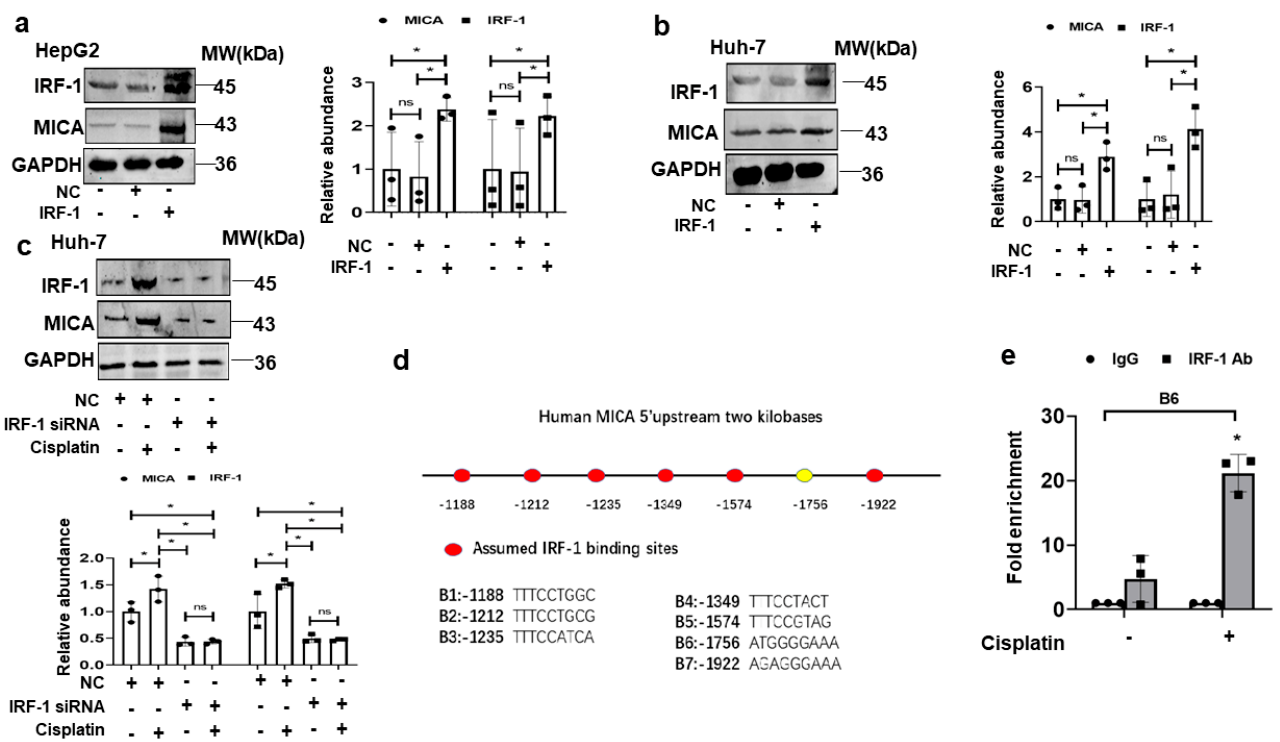
Figure 5. IRF1 promotes MICA transcription in response to DNA damage. The whole lysate for IRF1 and MICA protein determined by western blot is shown in HepG2 cell ( a ) and Huh-7 cell ( b ) infected by lentiviral IRF1 cDNA (50 MOI) for 48 h. The quantitative analyses are shown on the right. ( c ) The western blot for MICA and IRF1 protein expression was shown in Huh-7 cells induced by cisplatin at a dose of 10 uM with or without IRF1 siRNA transfection for 48 h. ( d ) The schematic representation of IRF1 binding sites in the human MICA promoter region as predicted by PROMO bioinformatics software are shown. ( e ) ChIP assay is performed with IgG or anti IRF1 antibody in Huh-7 cells, which are induced by cisplatin (10 uM) for 24 h. The qPCR analyses of immunoprecipitated DNA are conducted using the primers, designed to amplify the indicated region of the MICA promoter. Data represent the mean ± SD, * p < 0.05, ns not significant. The uncropped blots are shown in Supplementary Figure